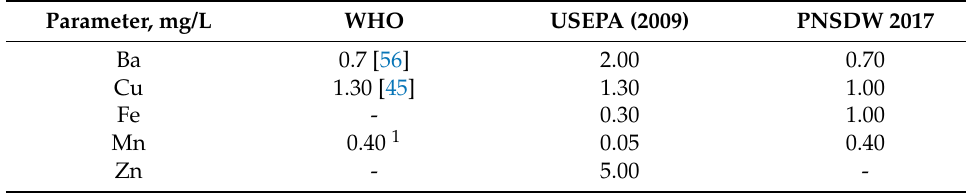
Table 2. Permissible limits of metals in groundwater.